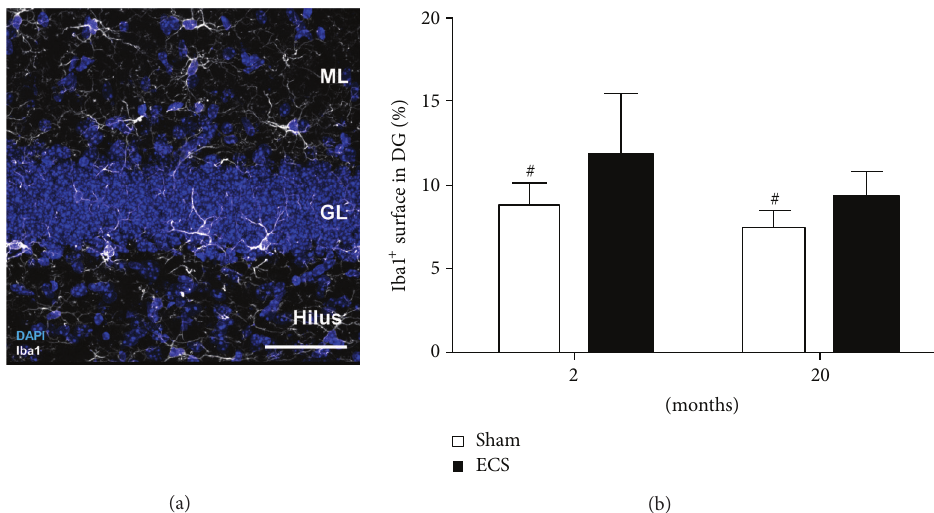
Figure4:(a)Detectionofmicrogliainthegranularlayer(GL)ofa2-month-oldmousebasedontheexpressionofIba1(white)(ML:molecular layer). Scale bar: 50 𝜇 m. (b) Microglia volume was estimated according to the percentage of the surface covered by Iba1 + labelling in the granular layer of 2- and 20-month-old mice following ECS or sham treatment. Two-way ANOVA revealed upon ECS a significant increase of Iba1-labeled surface in the dentate gyrus of both age groups ( 𝑃 = 0.0475